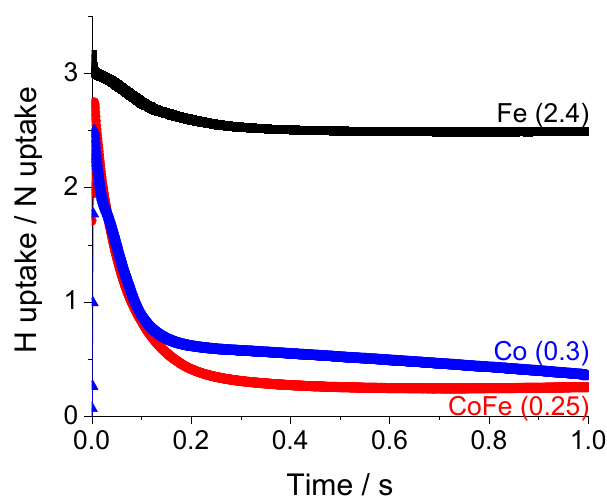
Figure 10. Dynamic hydrogen/nitrogen, (H/N), ratio determined from atomic accumulation data when ammonia is pulsed over Fe, CoFe and Co at 550 °C.